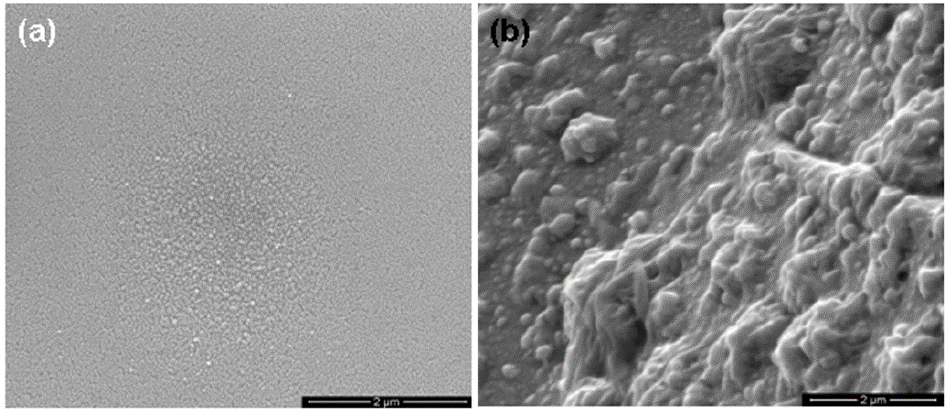
Figure 5. SEM images of 100 °C annealed porous GaAs (sample B). ( a ) surface, ( b ) cross-section view.